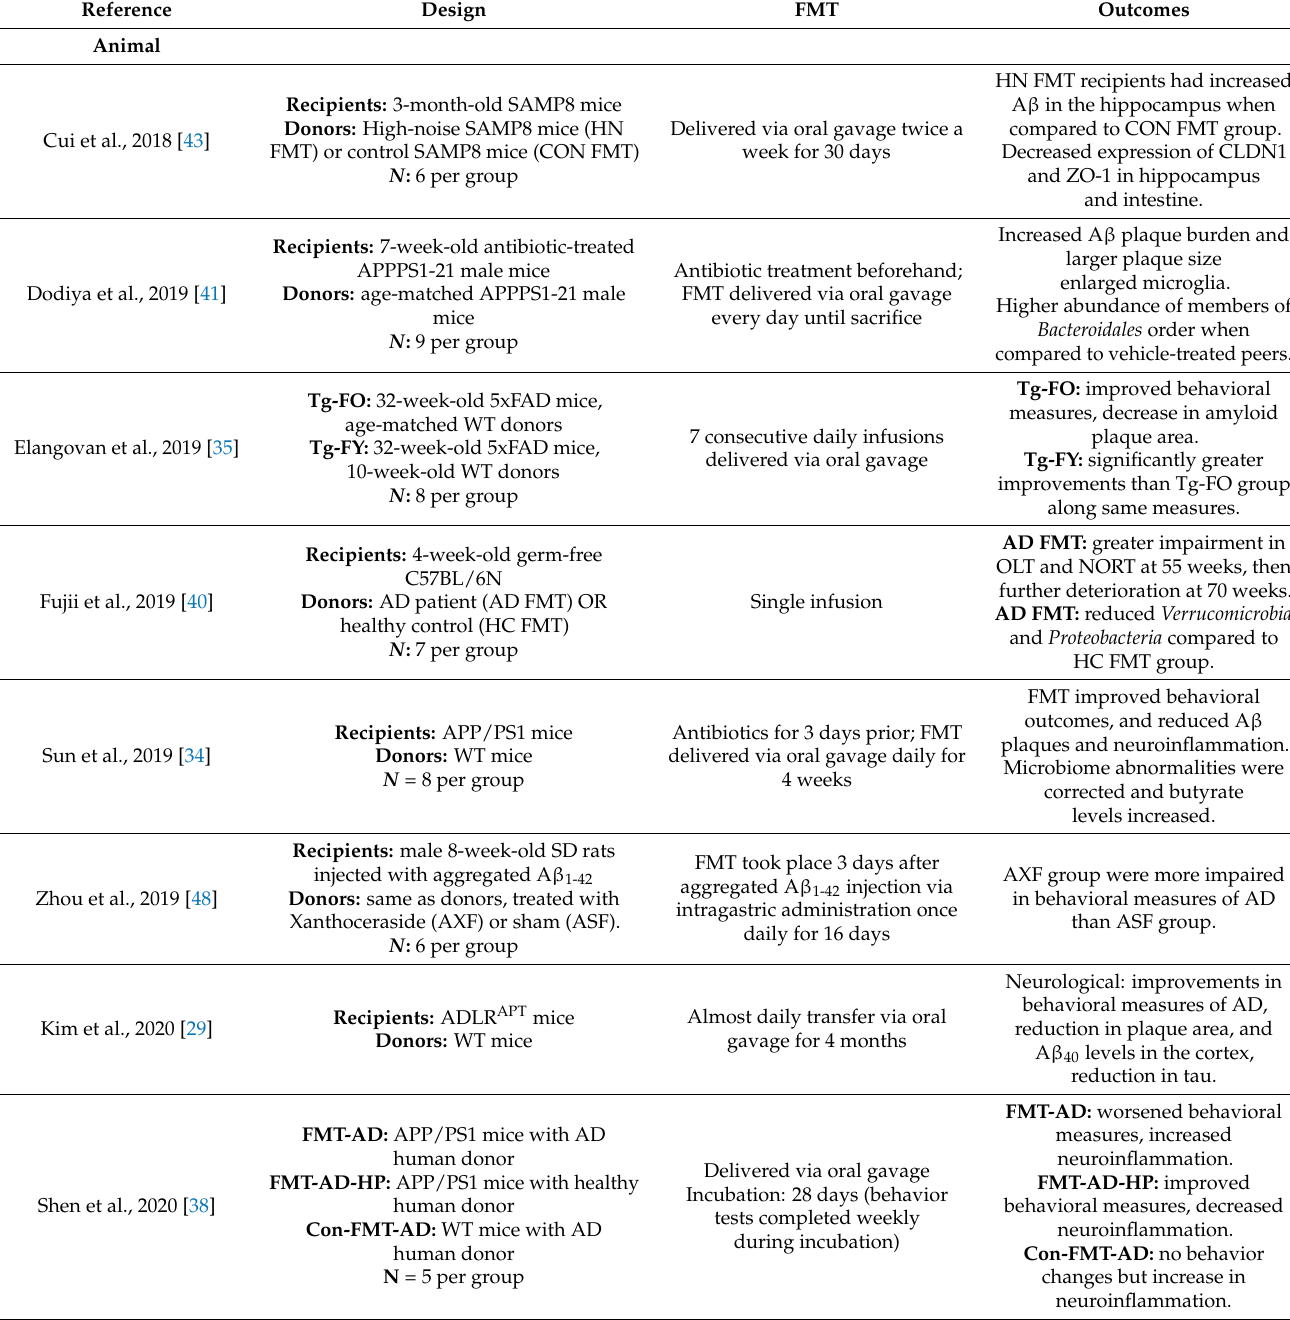
Table 1. AD research involving